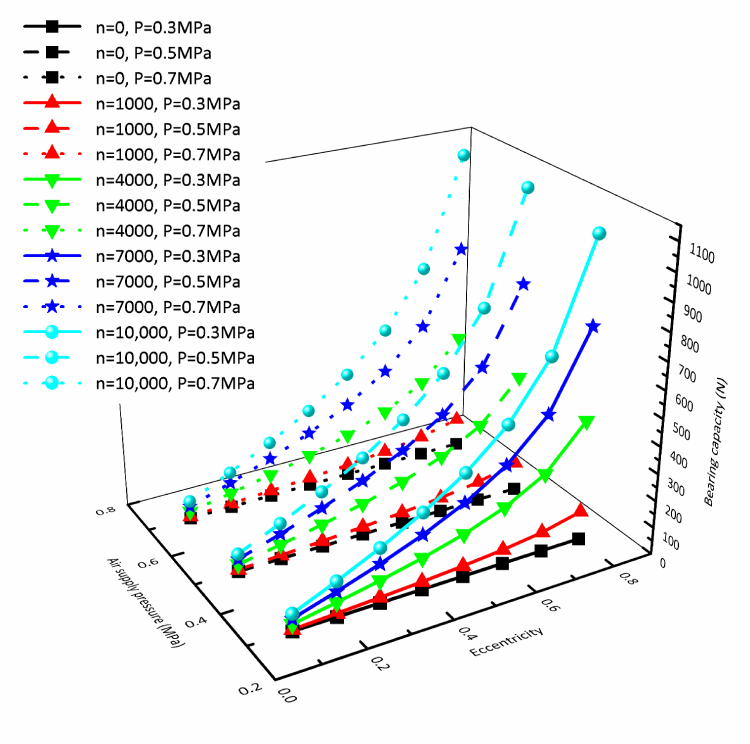
Figure 6. Influence of eccentricity on bearing